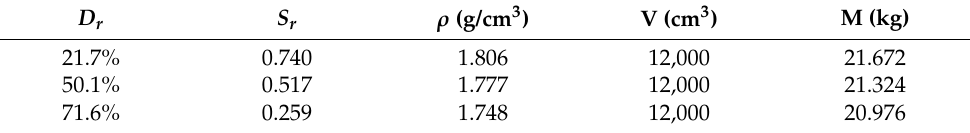
Table 2. The calculated results of the sand sample with different degree of compaction.